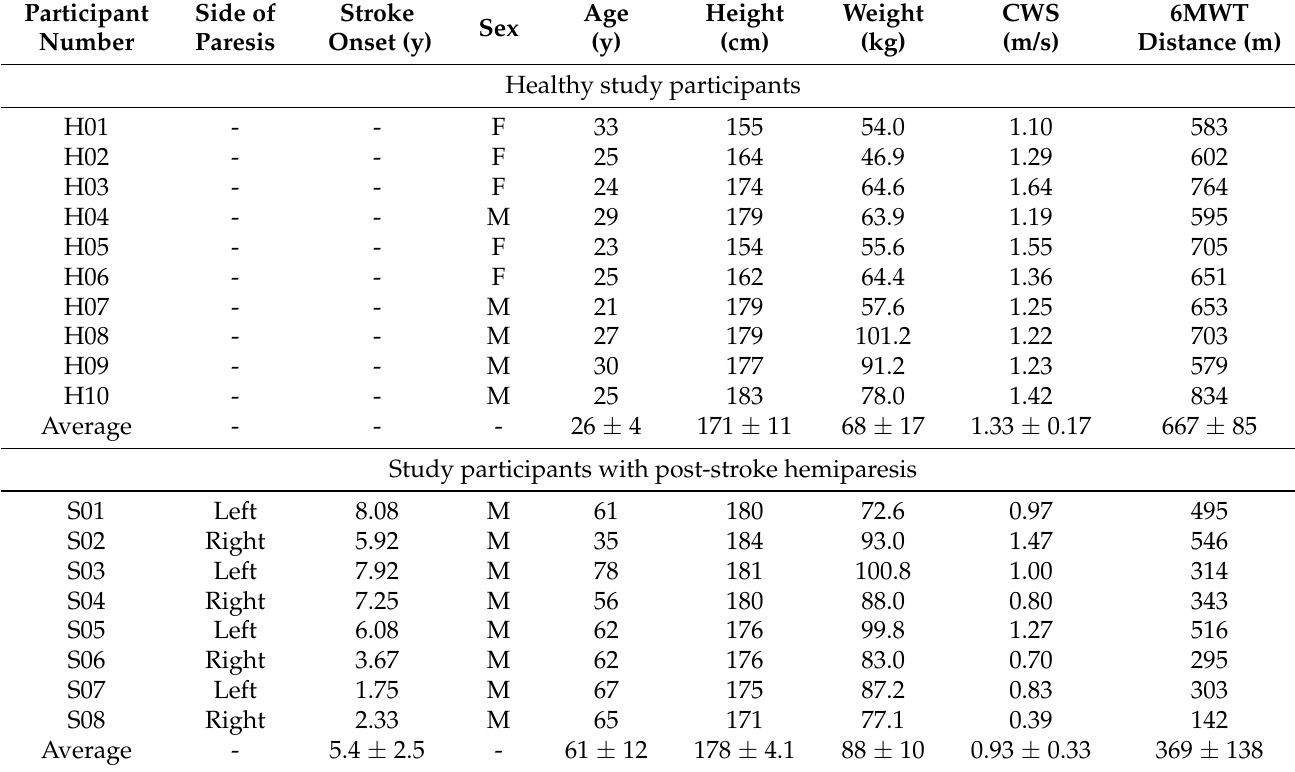
Table 1. Study participant